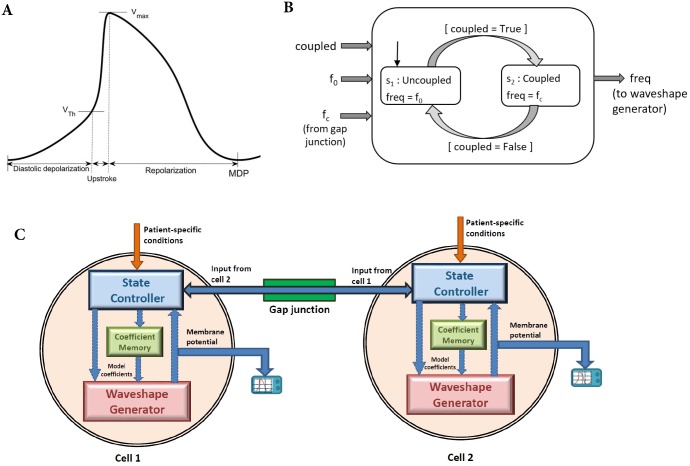
Coupling between two Resonant model sinoatrial node cells.A: Parameters of the action potential of sinoatrial node cell. MDP is a maximal diastolic potential, Vmax is the maximum potential, and VTh is the threshold potential. B: State controller of the Resonant model of a sinoatrial node cell. f0 is the intrinsic beating frequency of a cell and fc is the entrained frequency C: Diagram of the two Resonant model cells (Cell 1 and Cell 2) coupled with a gap junction.